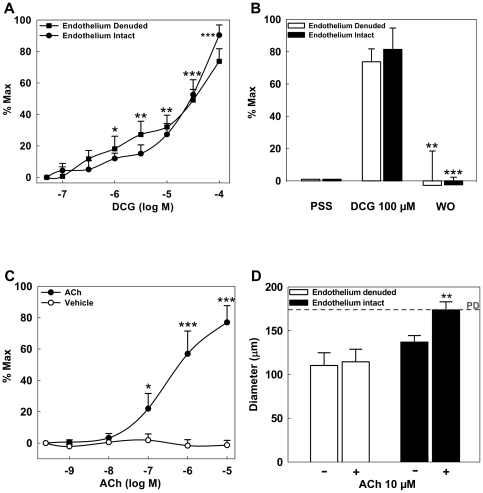
Effect of DCG and ACh on MT in rat 4th-order mesenteric arteries.(A) DCG induces concentration-dependent reduction of MT in endothelium-intact and -denuded arteries. Asterisks indicate significance when compared to the baseline for both preparations. (B) DCG (100 µM) reduced MT in endothelium-intact and -denuded arteries. This effect was reversed by washing with PSS; (WO-Wash out). Asterisks indicate significance when compared to DCG (100 µM)-mediated response in respective arterial preparations. (C) ACh induced concentration-dependent reduction of MT. There was no effect in vehicle-treated arteries. (D) Addition of 10 µM ACh had no effect on endothelium-denuded preparations while endothelium-intact preparation achieved diameters similar to passive diameter. Asterisks indicate significance when compared to untreated endothelium-intact arteries. The dashed-line represents passive diameter (PD). PD is the lumen diameter when VSM is completely inactive. (n = 4–5 arteries in each group).